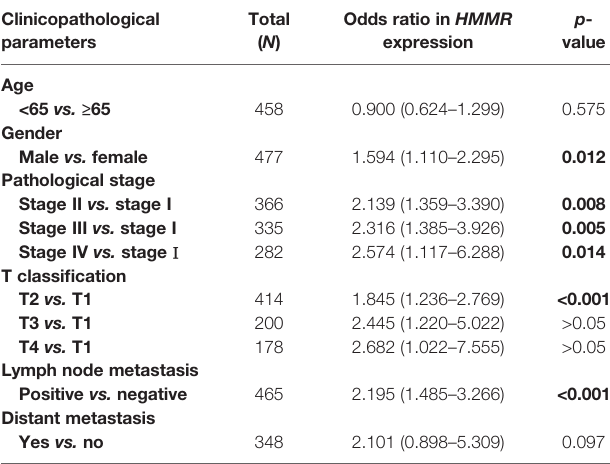
TABLE 4 | HMMR expression correlated with clinicopathological parameters. Clinicopathological parameters